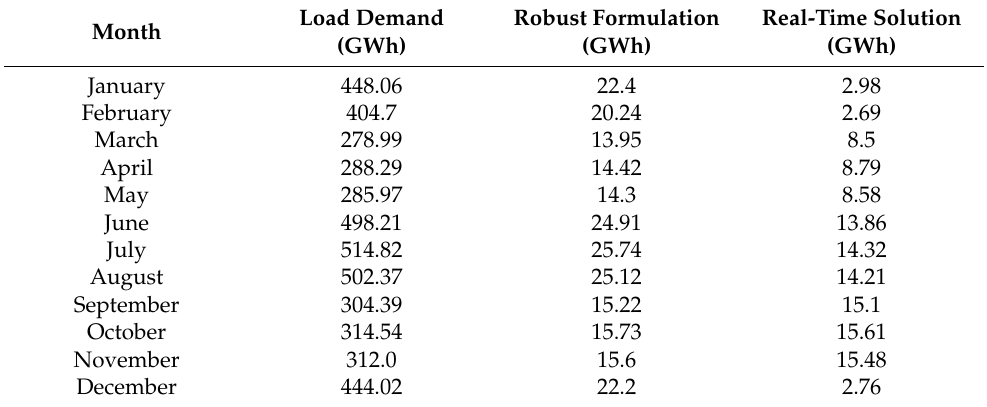
Table 1. Spinning reserve comparisons pertaining our proposed solution and robust